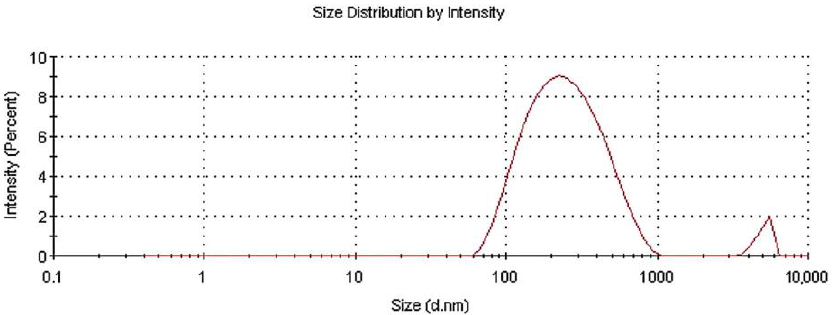
Figure 2. Size distribution for N-TiO 2 powder dispersed in water.